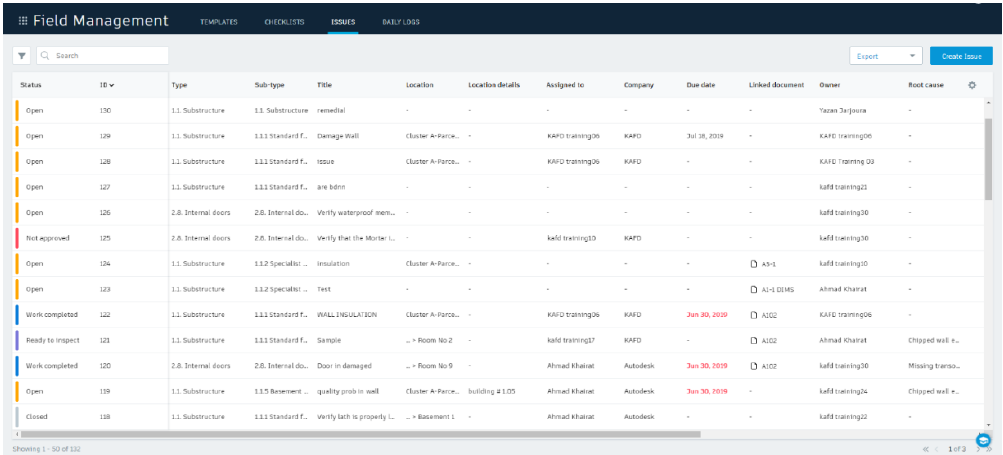
Figure 12: The List of Issues in BIM 360 Build